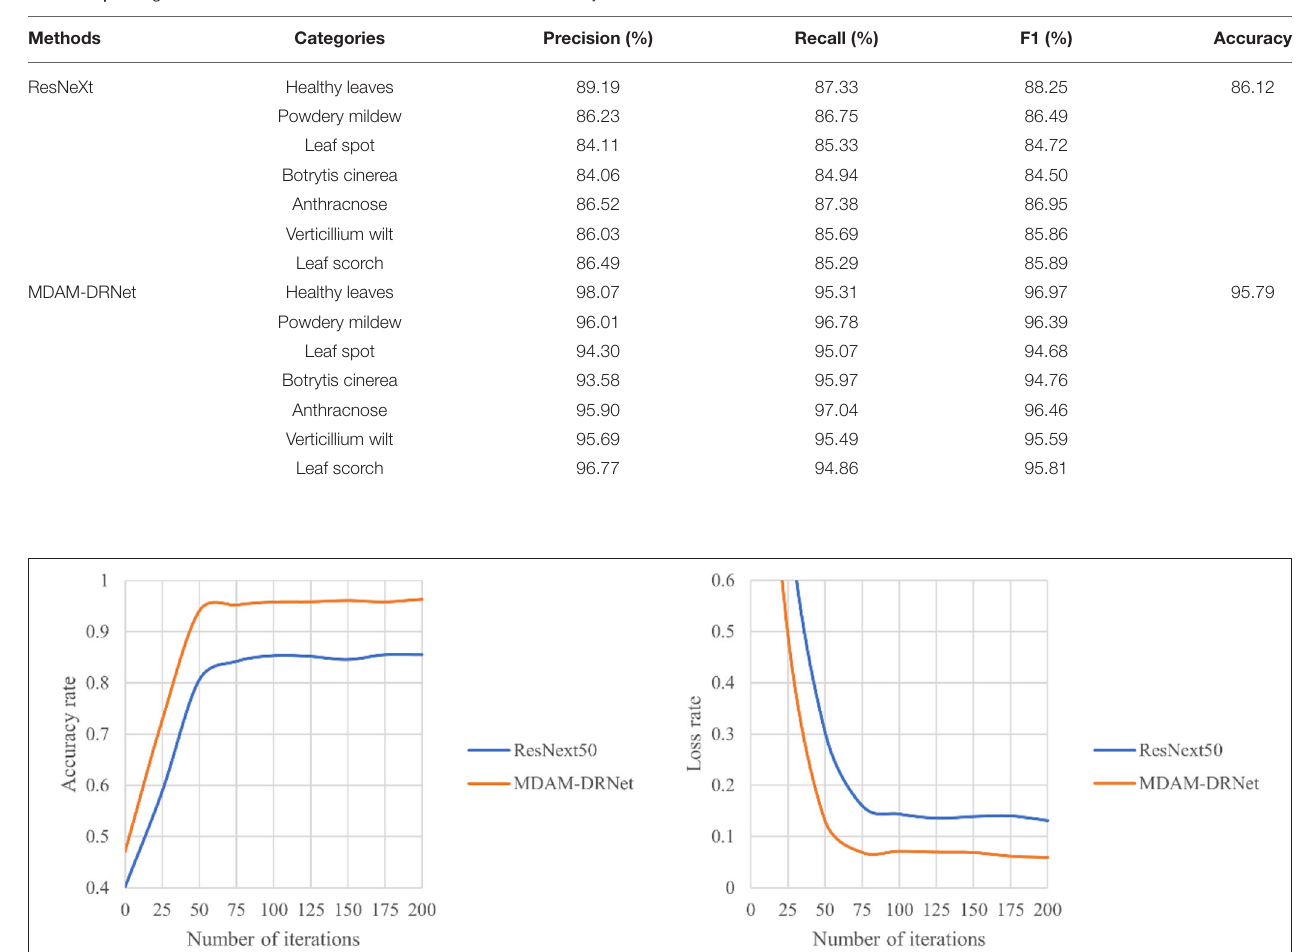
TABLE 6 | Recognition results of ResNeXt and MDAM-DRNet for strawberry leaf diseases.